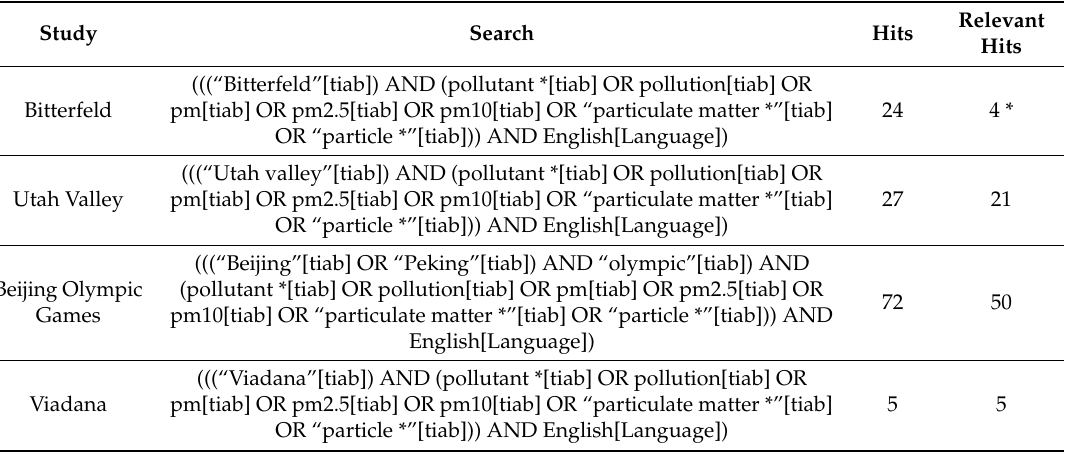
Table 1. A list of the searches in the PubMed database (up to 25 October 2019) completed for the examples presented in this